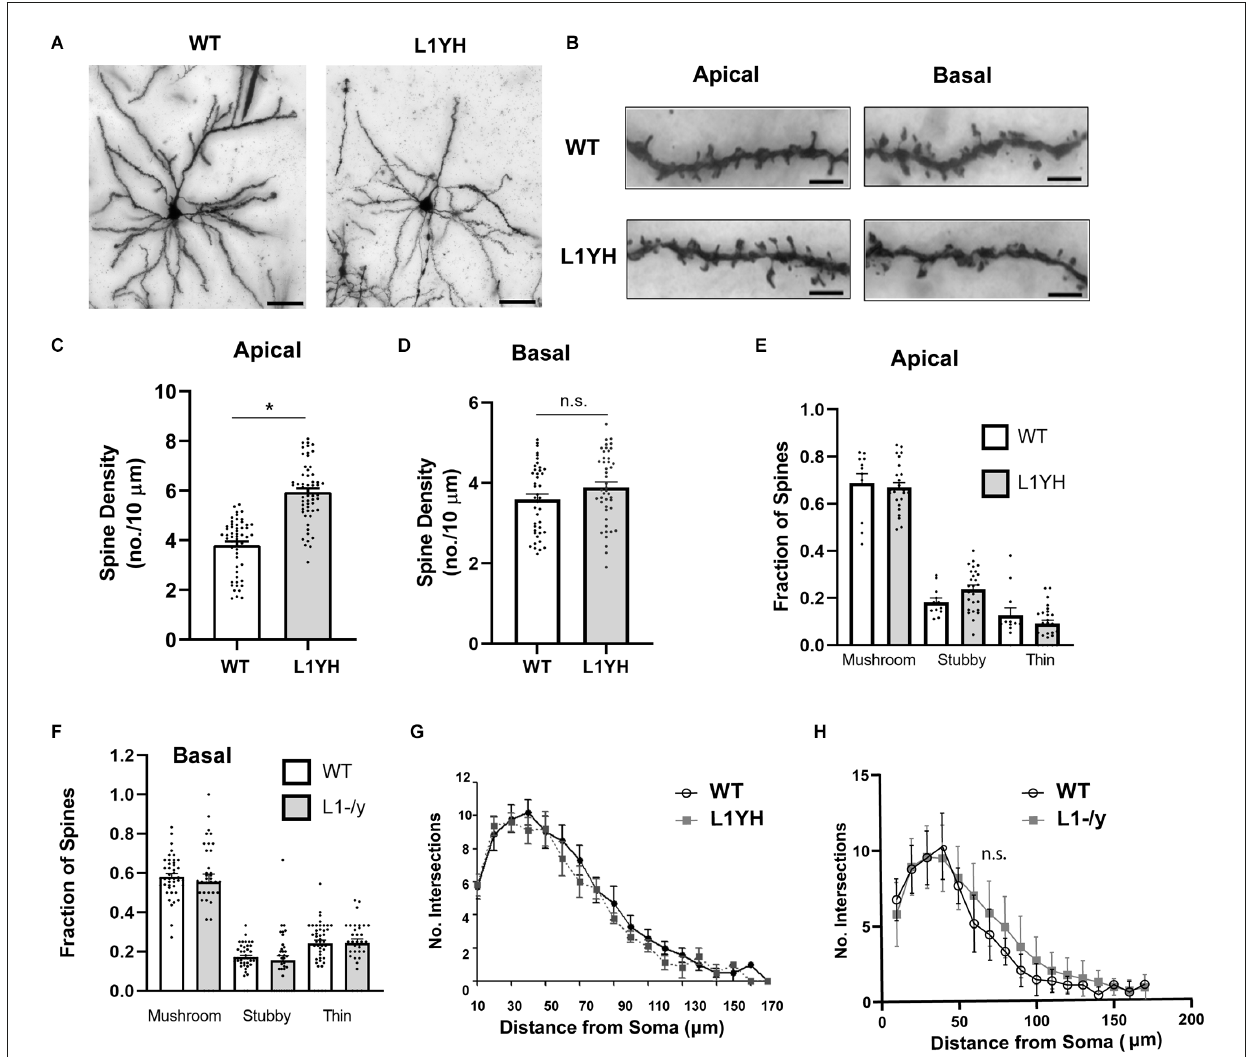
FIGURE2 L1YH mutation increases spine density on apical dendrites but has no effect on dendritic branching. (A) Representative images of Golgi-labeled pyramidalneuronsinPFClayer2/3ofWTandL1YHmice.Scalebars=80 µ m. (B) RepresentativeimagesofapicalandbasaldendritesofGolgi-labeled pyramidal neurons in PFC layer 2/3 of WT and L1YH mice. Scale bars = 8 µ m. (C) Mean spine densities on apical dendrites of layer 2/3 pyramidal neurons in the L1YH PFC were significantly increased compared to WT. WT (3.8 spines/10 µ m ± 0.1); L1YH (5.9 spines/10 µ m ± 0.2; * p <